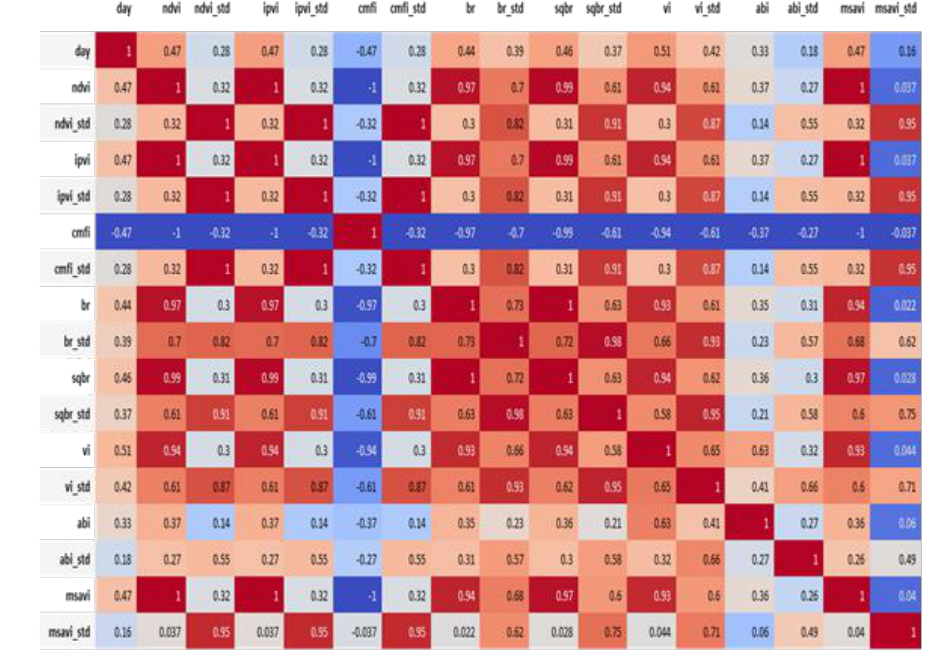
Figure 18. Correlations between vegetation index features and cabbage growth stages.